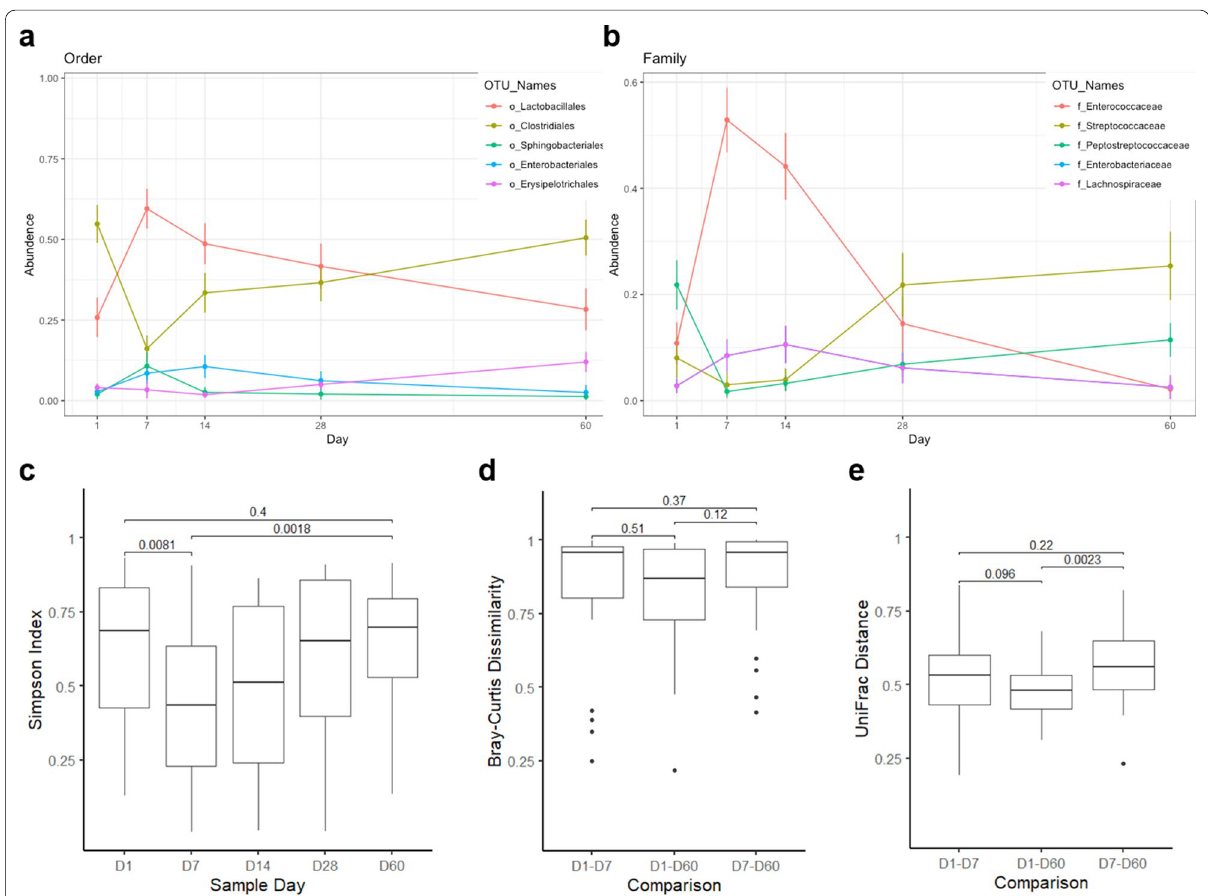
Fig. 8 Changes in fecal microbiota composition over the study period. Taxa are visualized by order ( a ) and family ( b ). Points bars represent the median relative abundance and interquartile range of the five most abundant taxa across the 25 samples for which 16S data were available at all 5 time points. Families are given the same color as their parent orders. Simpson’s Diversity Index of samples at each time point, with Wilcoxon signed rank P ‑values comparing D1, D7, and D60 samples ( c ). Beta diversity between D1, D7 and D60 samples from the same patient, measured by Bray– Curtis dissimilarity ( d ) and UniFrac distance ( e ) and labeled with Wilcoxon signed rank P